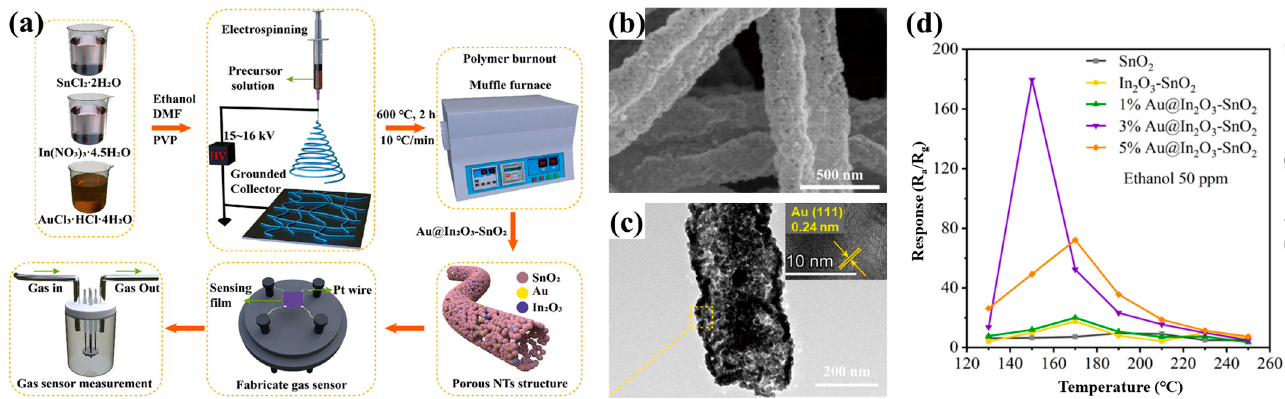
Figure 13. ( a ) Schematic diagram of the designed gas sensor of the porous Au@In 2 O 3 -SnO 2 nanotubes; ( b – c ) SEM and TEM images of 3% Au@In 2 O 3 -SnO 2 ; ( d ) response variation to ethanol of different sensors at different temperatures. Reprinted with permission from Ref. [172], Copyright 2023, Elsevier.